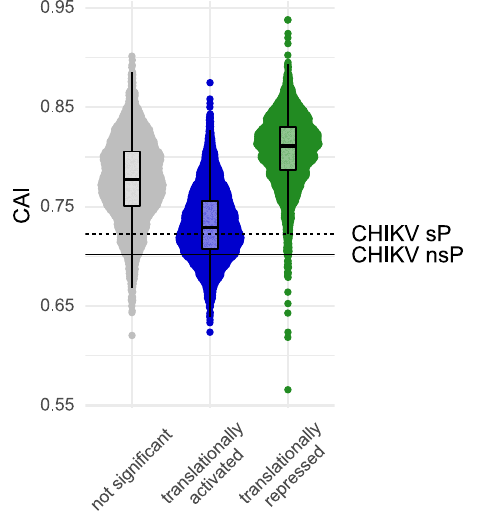
Fig. 3 CHIKV RNA and translationally activated mRNAs feature low CAI values. Distribution of codon adaptation index (CAI) among different translational groups at the ER. Each dot represents one gene. Horizontal lines indicate CAI of CHIKV ORFs: continuous line - NSP, dashed line - SP. Upper and lower limits of the box correspond to the 1st and 3rd quartile score distribution with whiskers extending to 1.5 times the range from top/ bottom of the box. The line represents the median. Translationally activated mRNAs n = 4726, translationally repressed mRNAs n = 3875, not signi fi cantly changed mRNAs n =